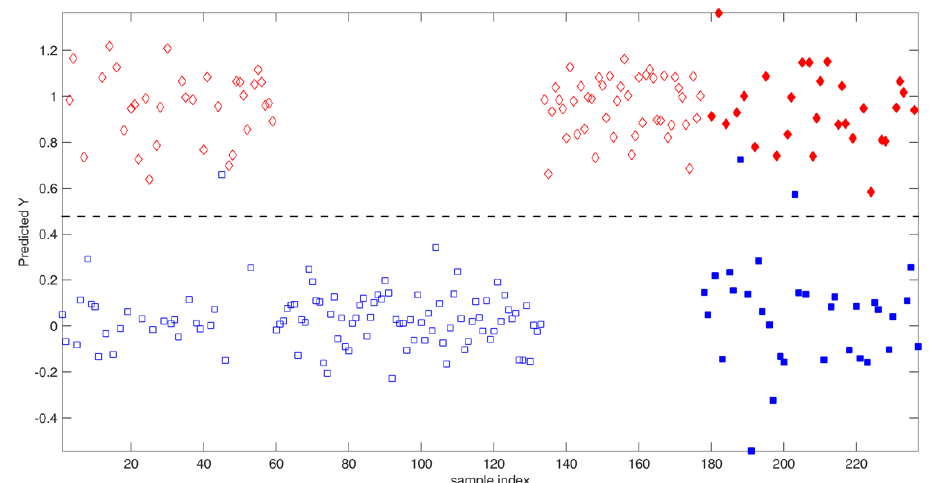
Figure 5. PLS-DA analysis: Predicted Y vs. sample index. Legend: Class Sorrento: Red diamonds; Class Non-Sorrento: Blue squares. The black dashed line represents the threshold between the two classes (Sorrento for y > threshold; Non-Sorrento for y < threshold). Empty and filled symbols represent training and test samples, respectively.